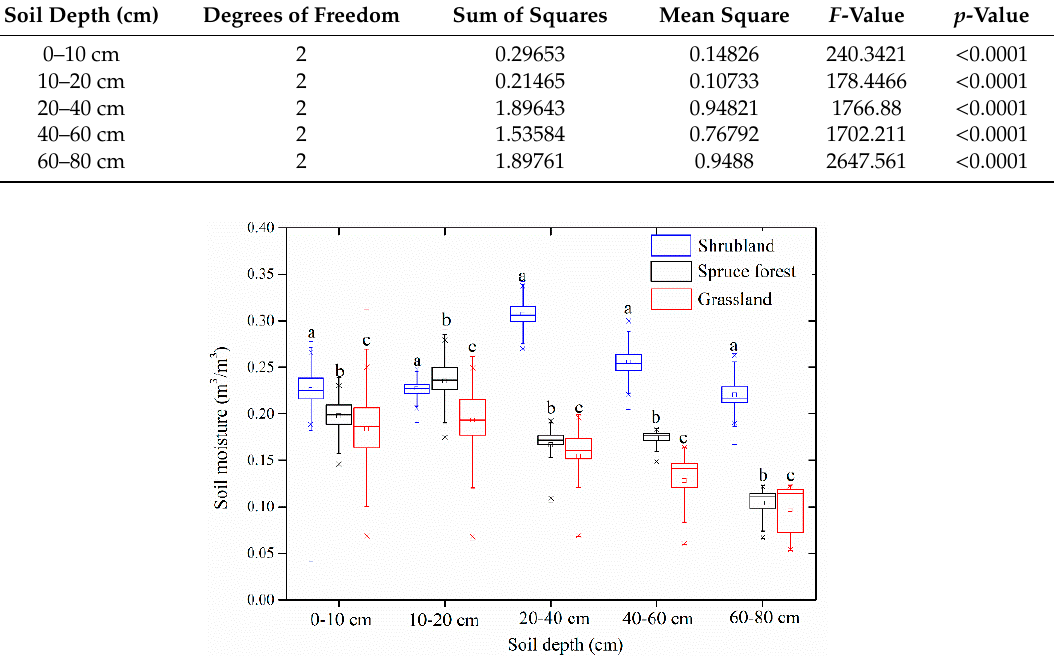
Figure 3. Analysis of soil moisture at multiple depths under different vegetation types during the growing season. The statistical differences are shown using a, b, and c ( n = 120).